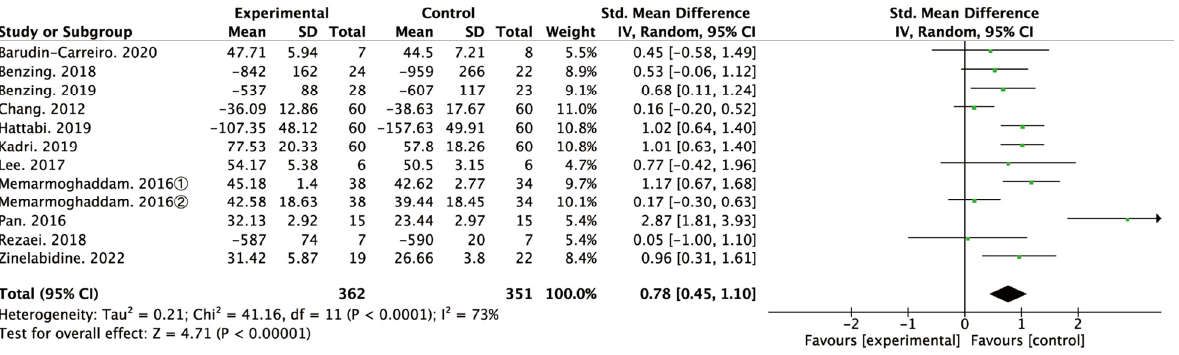
Figure 3. Forest plot of meta-analysis of PA on inhibition [29,38,42–50].